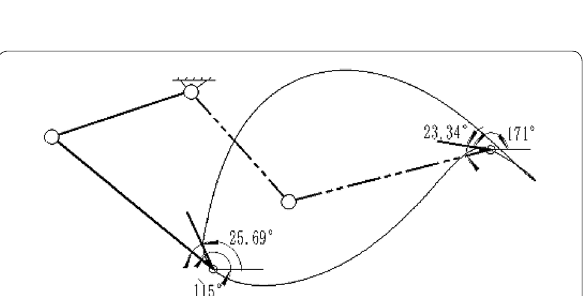
Figure 6 Mechanism before adjusting the rod length Figure 5 is a schematic of the established seedling pick- up mechanism along with the seedling pick-up trajectory, point 1, and point 5. In this figure, the angle between rod II and the seedling claw (the intersection angle) is 25.74°.